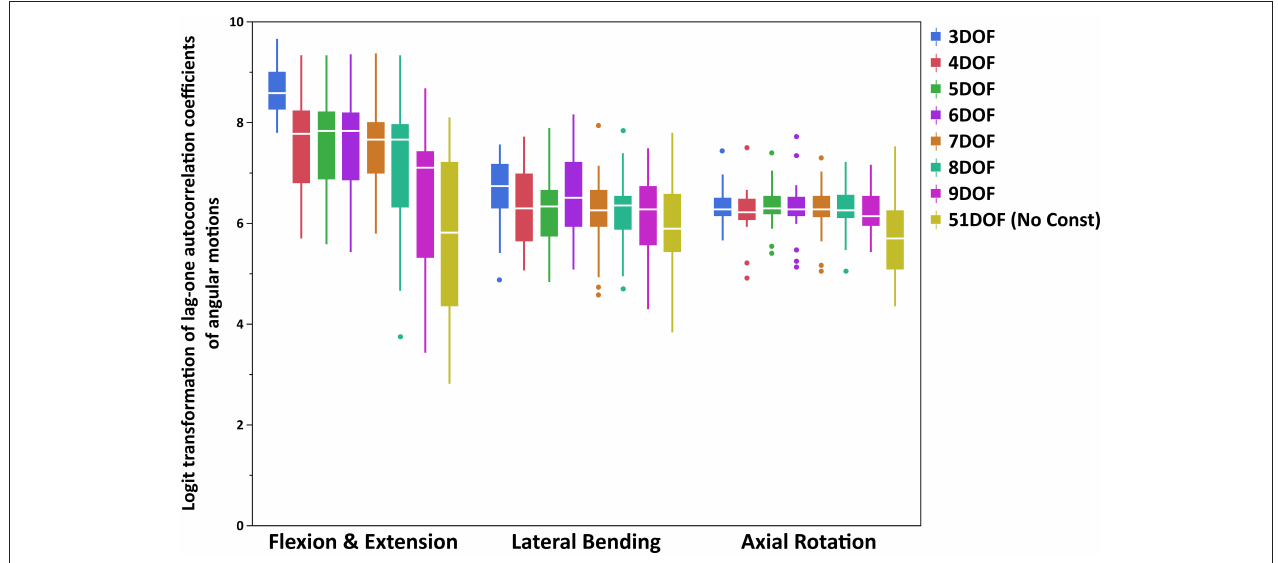
FIGURE 2 | Boxplot of logit transformed lag-one autocorrelation coefficients of angular motions for each primary direction of tasks (FE, LB, and AR). Note that logit transformed autocorrelation values extend from 0 (least smoothness ) to 10 ( smoothest ). FE, flexion–extension; LB, lateral bending; AR, axial rotation.